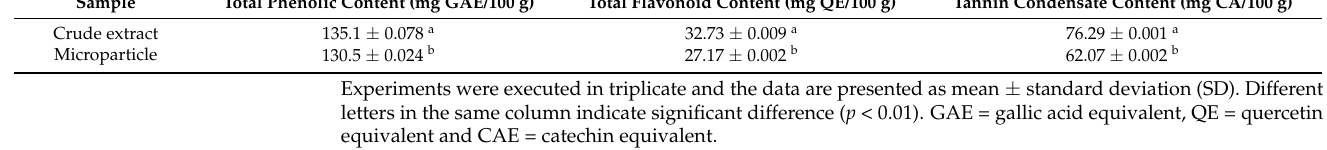
Table 1. Quantification of polyphenols content in the crude extract (CE) and microparticle (MP). Sample